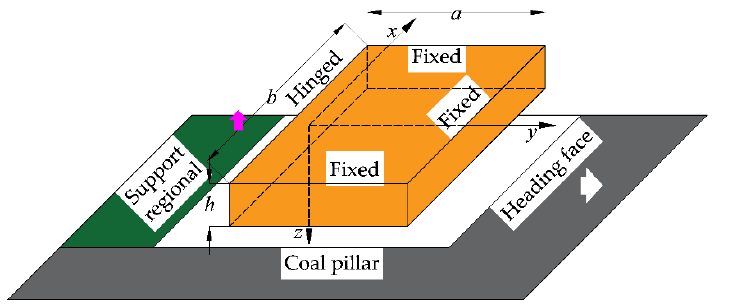
Figure 1. Thin plate model of direct roof in heading face.